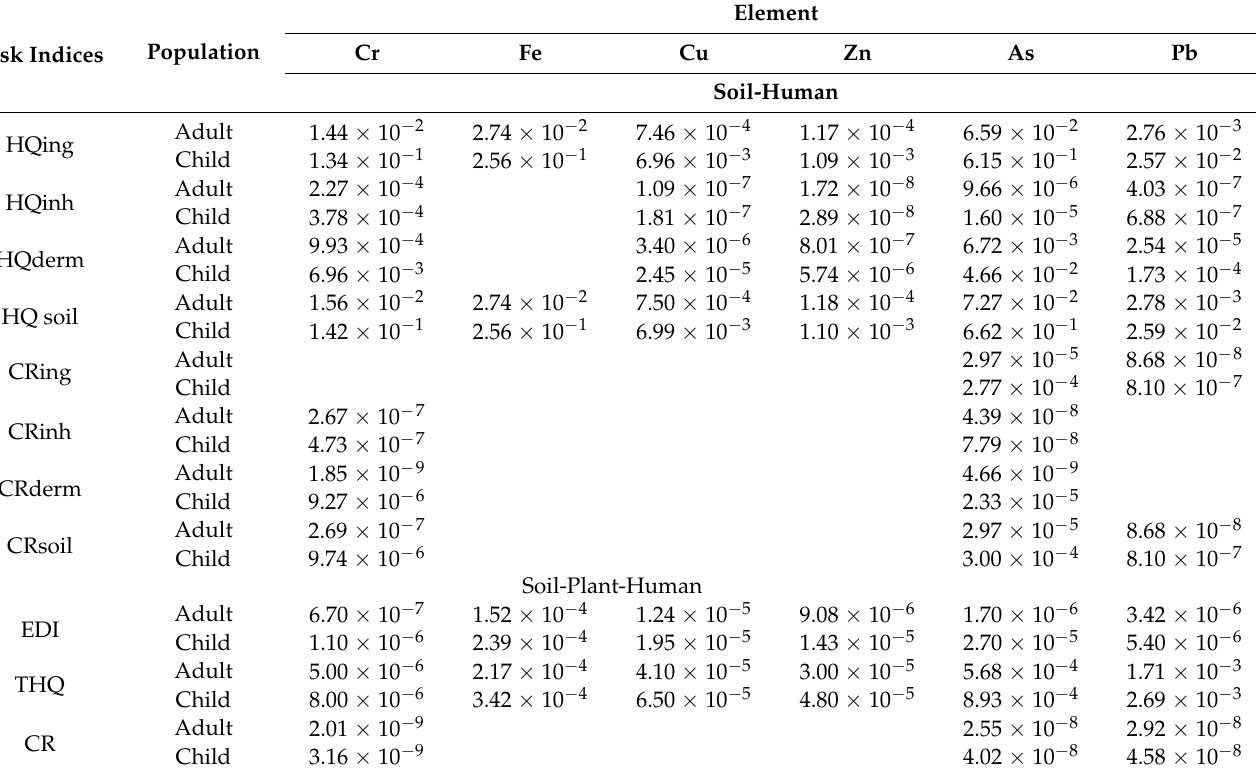
Table 7. Health risk assessment value from soil-human and soil-vegetable-human